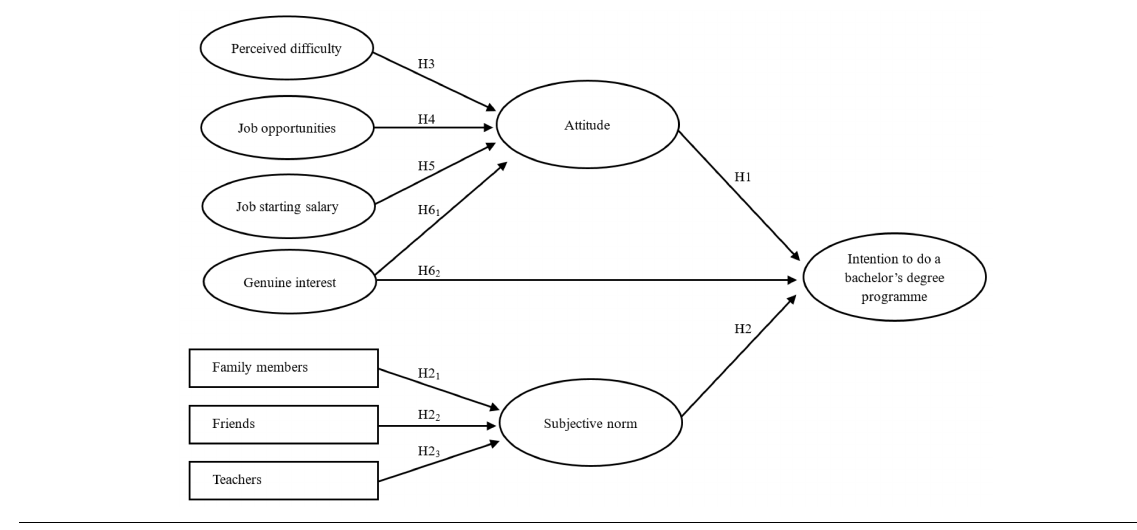
Figure 2. Conceptual framework for measuring factors which determine the intention of logistics sub-degree students to pursue a bachelor’s degree (Source: Authors,